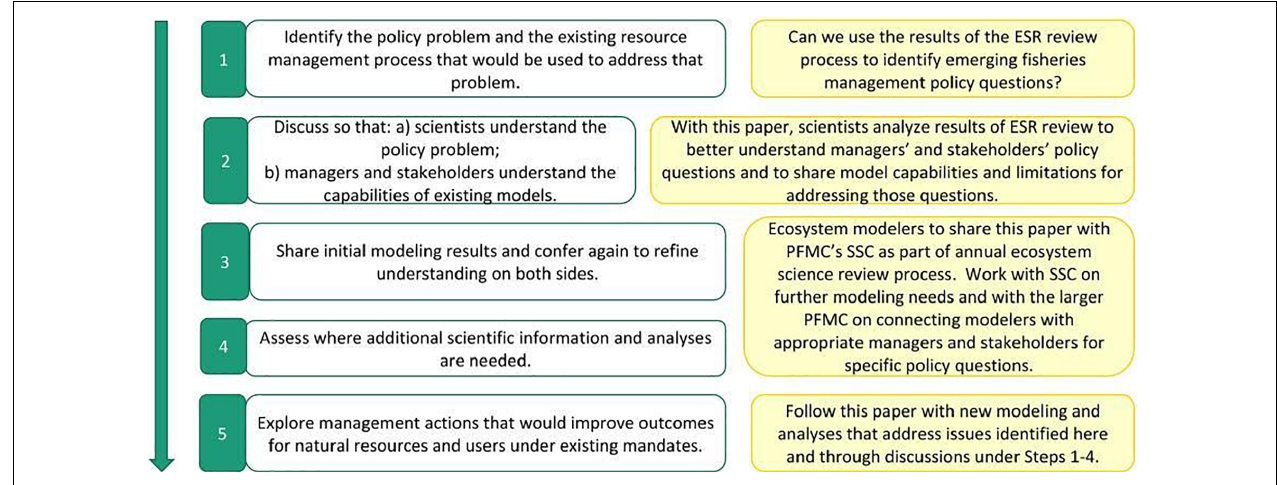
FIGURE 1 | Overview of the process to facilitate integration of ecosystem models and analyses into fisheries management proposed by Townsend et al. (2019) on left and adaptation of that process to address multiple issues as presented in this paper on right.